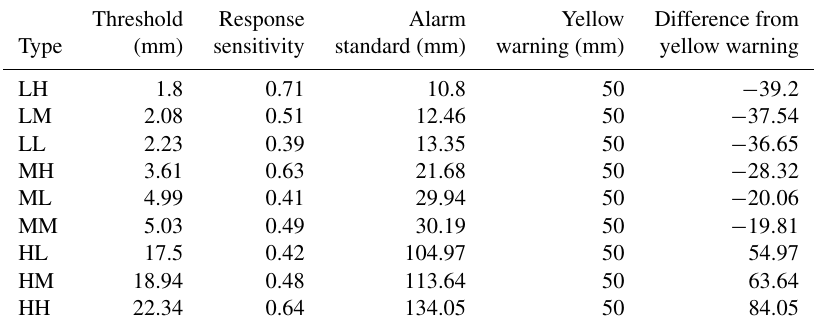
Table 1. Urban resilience indices from this study for different city groups and the difference from the current yellow Chinese heavy-rain-alert standard. Note that the different types of urban resilience are defined in Fig.